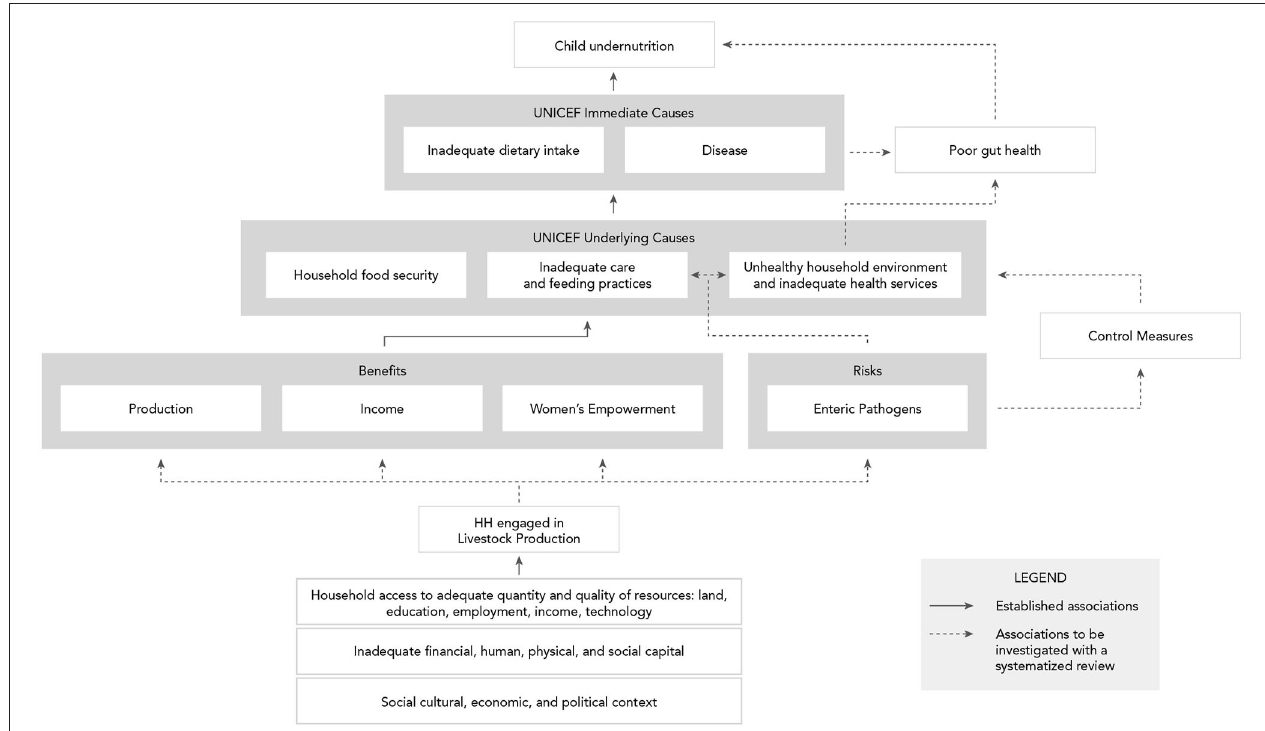
FIGURE 1 | Conceptual framework of benefits and risks of smallholder livestock production on child nutrition in low- and middle-income